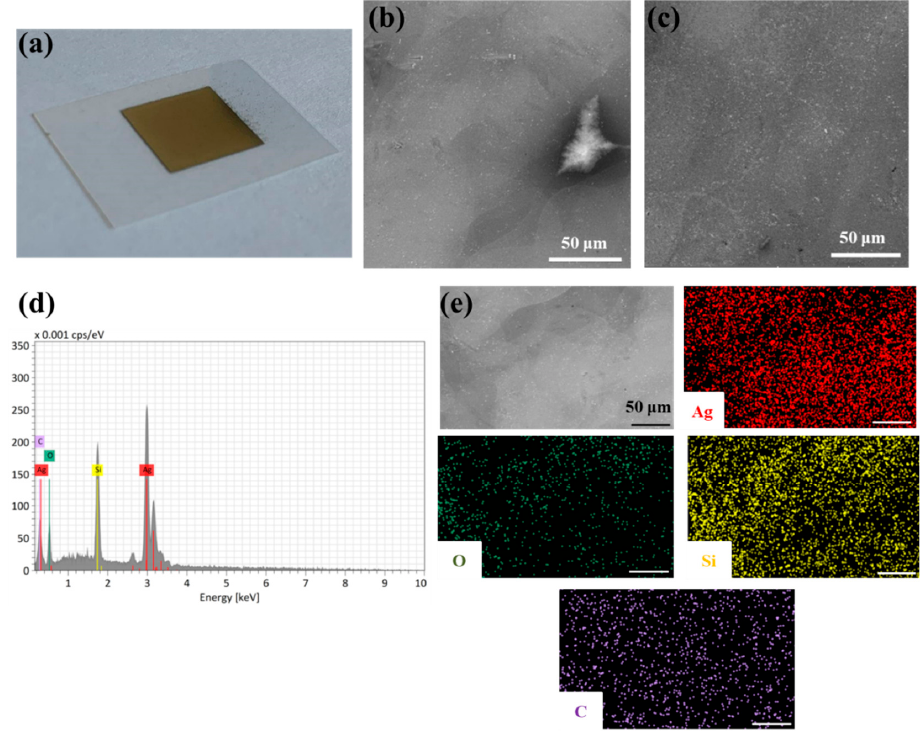
Figure 12. ( a ) Image of the printed silver square on a coated PET substrate before annealing, and SEM micrographs of the thin-film surface ( b ) before and ( c ) after IPL annealing; ( d ) EDX spectra and ( e ) elemental mapping of the prepared conductive features. Shown at 1000× magnification; scale bar 50 μ m.